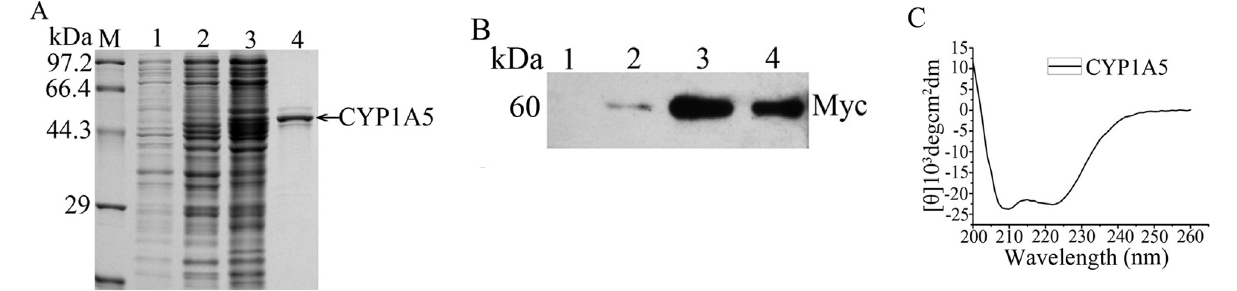
Figure 4. Expression, purification, secondary structure and Western blot detection of recombinant CYP1A5. The prokaryotic expression and purification of CYP1A5 were analyzed by 12% SDS-PAGE gels with Coomassie blue staining ( A ) and Western blotting using anti-myc antibodies ( B ). M: marker; 1: non-IPTG-induced; 2: IPTG-induced total cell lysates; 3: solubilized membrane fraction; 4: FPLC-purified CYP1A5. ( C ) The secondary structure of recombinant CYP1A5 was